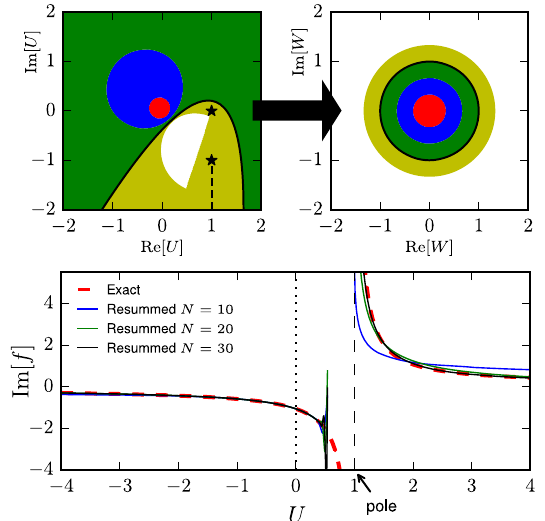
FIG. 18. Resummationoftheseriesof f ð U Þ¼ 1 = ln ½ i ð 1 − U Þþ 1 (cid:2) near U ¼ 0 on the real positive axis, beyond the pole at U ¼ 1 . f has a pole at U ¼ 1 and a branch cut starting at U ¼ 1 − i and going in a straight line toward 1 − i ∞ (stars and dashed line in top left). We isolate these singularities by applying a con- formal map W ¼ ½ χ ð U Þ − χ ð 0 Þ(cid:2) = ½ χ ð U Þ − χ ð 0 Þ (cid:4) (cid:2) , with χ ð U Þ ¼ ffiffiffiffiffiffiffiffiffiffiffiffiffiffiffiffiffiffiffiffiffi p − i . It maps the inside of a parabola into the outside i ð U − 1 Þ =p of the unit disk (left and right top). p controls the direction and width of the parabola. Here, p ¼ 0 . 2 e i π × 0 . 4 . With N ¼ 30 terms, one can compute f for all real U (black plain line) except a narrow band around the pole (dashed black vertical